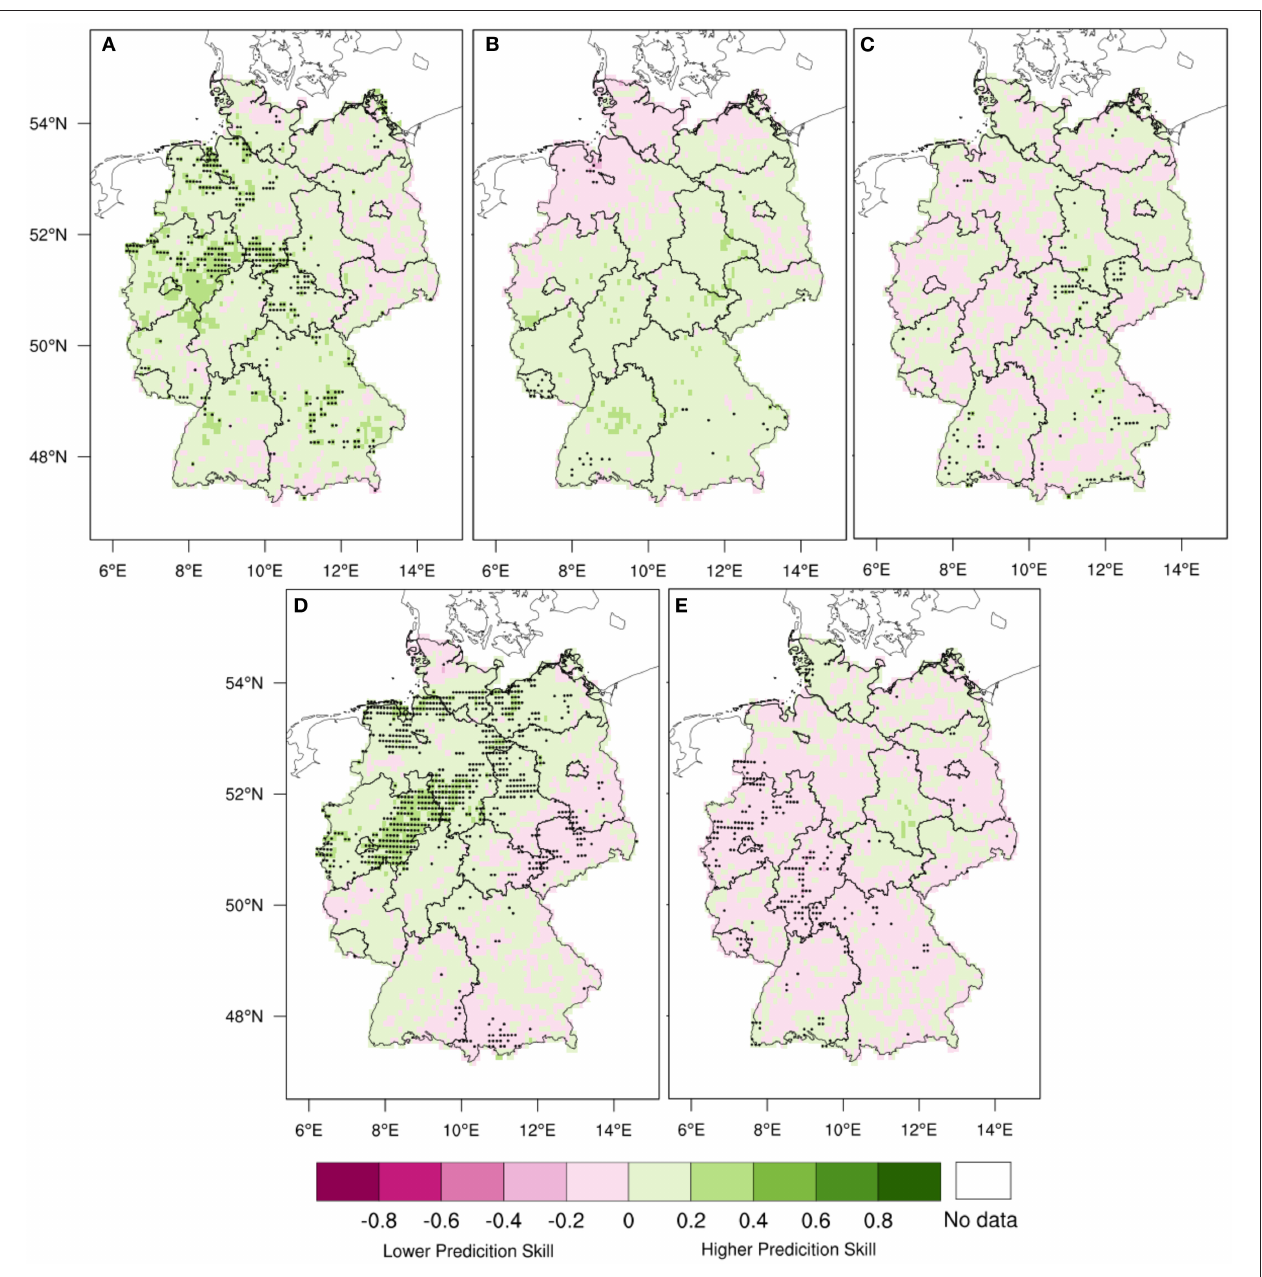
FIGURE 5 | Decadal prediction skill for 3-year SPI of January–December (A) , February–April (B) , May–July (C) , August–October (D) and November–January means (E) for forecast years 1–3 in the evaluation period 1962–2020 (1962–2019 for November–January): RPSS of EPISODES at optimized recalibration compared to the observed HYRAS climatology as reference prediction. Dots indicate significant skill (significance level of